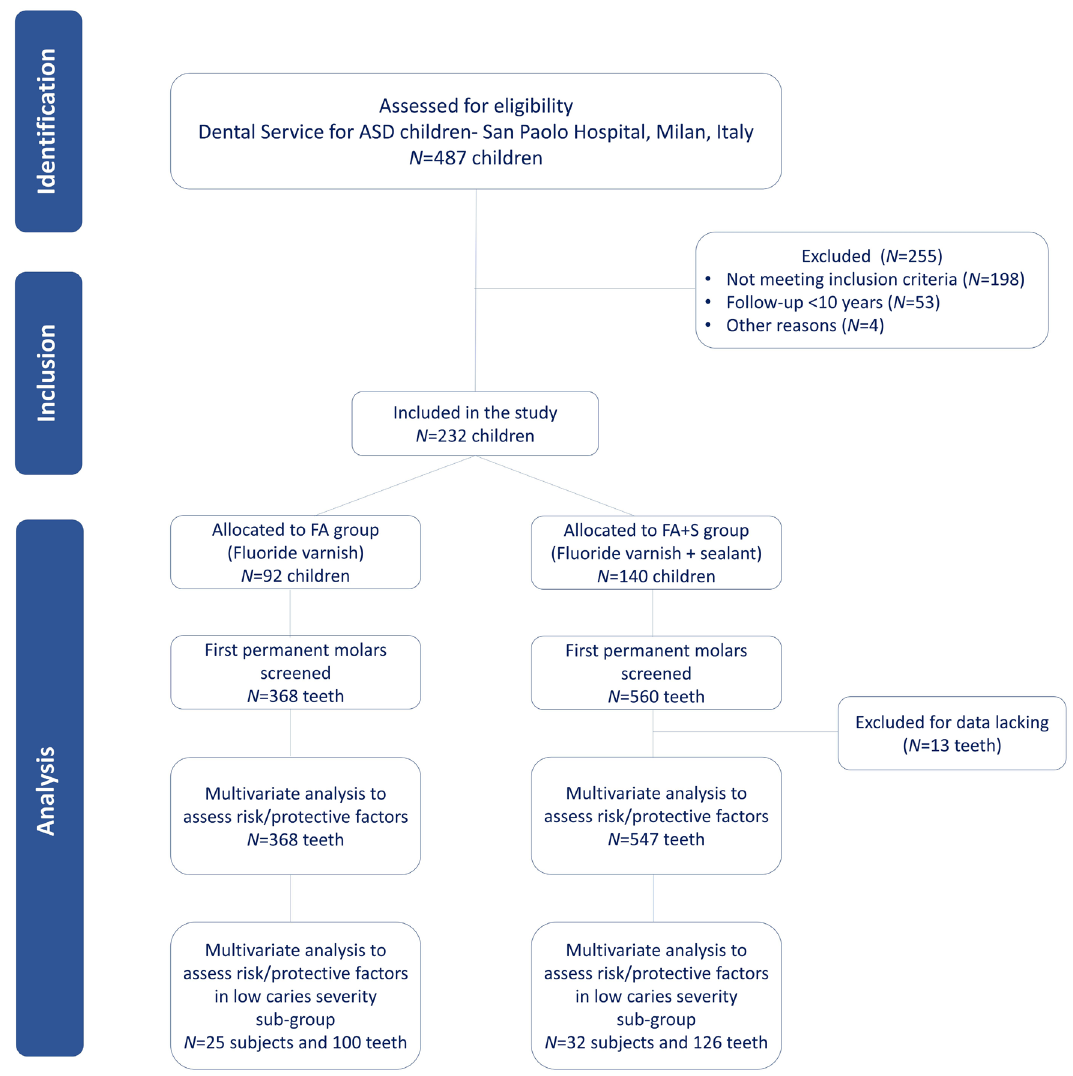
Figure 1. Study flow-chart according to STROBE (Strengthening the Reporting of Observational Studies in Epidemiology)